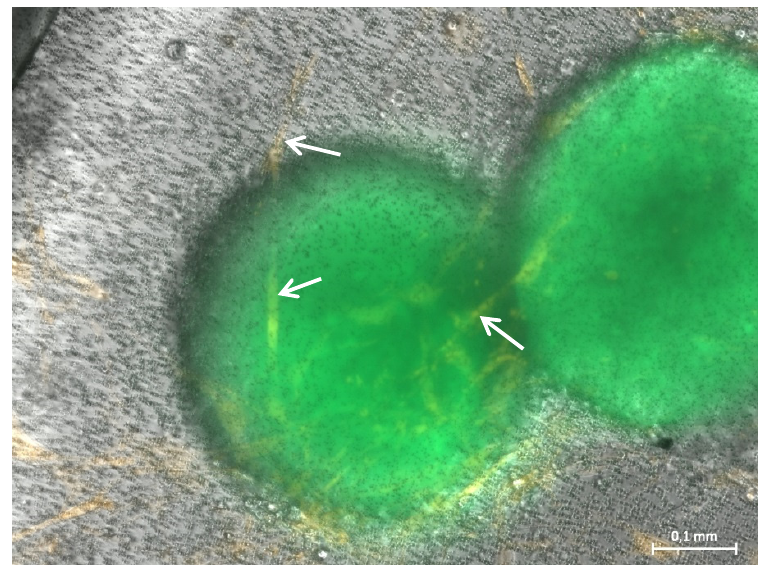
Figure 6. Representative merged brightfield and GFP/RFP fluorescence picture of a hydrogel culture on day 11, containing spheroids of GFP-transfected HCT116 (green), RFP-transfected fibroblasts (orange), HUVEC cells, macrophages and neutrophils. In these cultures with optimized cell numbers, fibroblasts show their spindle-shaped morphology (arrows). Measuring bar: 100 µm.